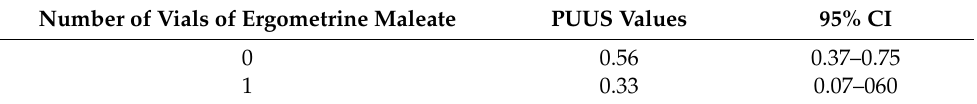
Table 14. The PUUS values of patients regarding the number of ergometrine maleate vials received. Number of Vials of Ergometrine Maleate